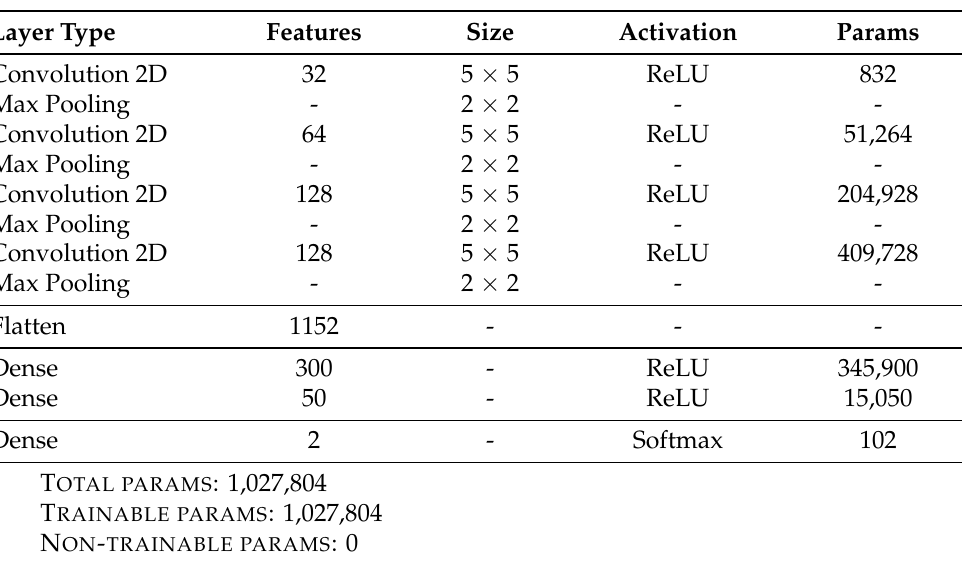
Table 2. Layer-by-layer summary of the proposed CNN model. Each layer name is given followed by the number of feature maps (convolutional layers) or neurons (dense layers), the size of the convolutional filter or pooling region, the activation function used and, last, the number of parameters to